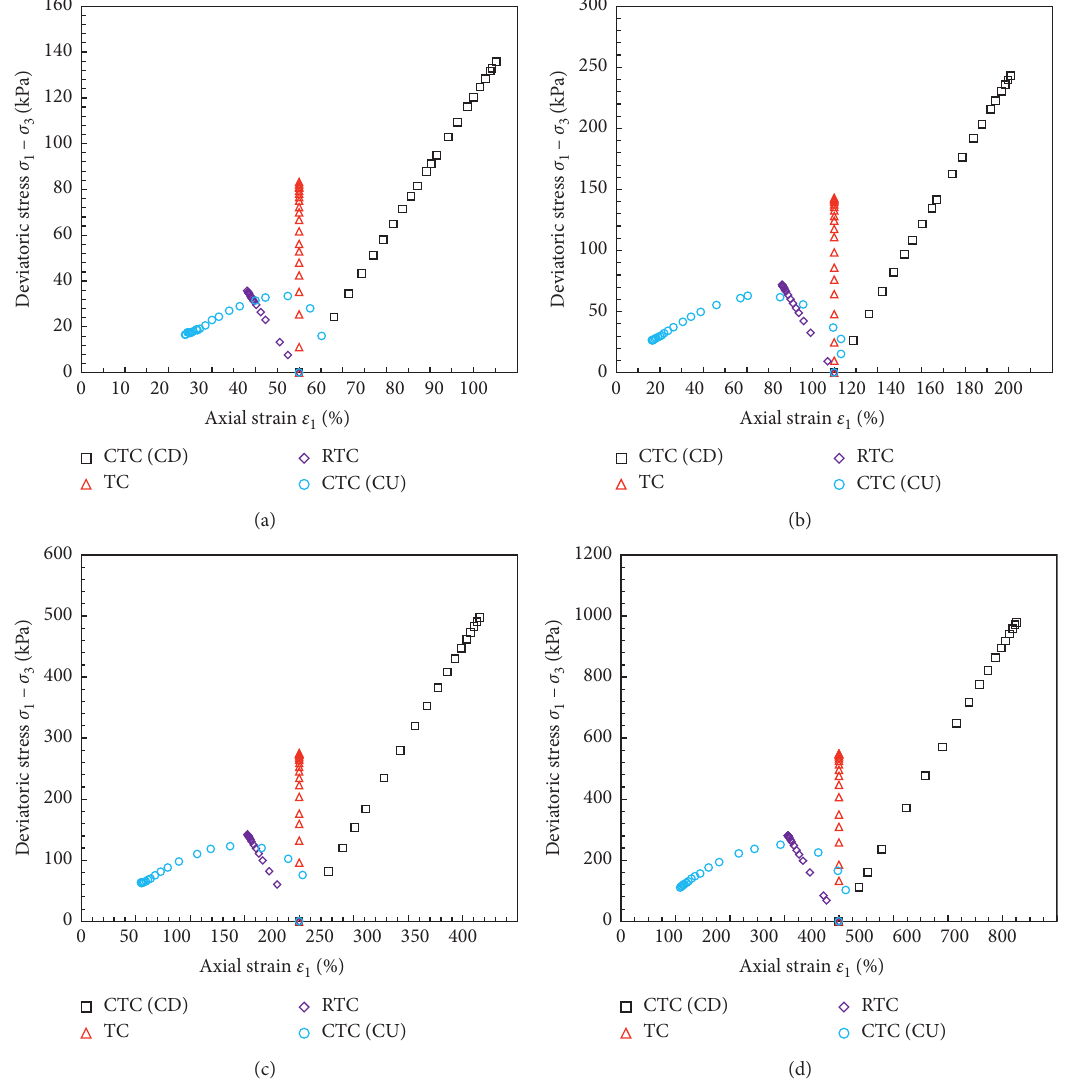
� 50kPa; (b) σ � 100kPa; (c) 3 3